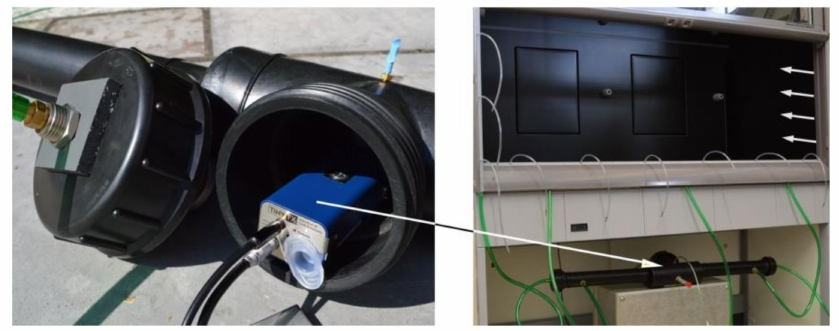
Figure 15. Experimental setup for visualizing the jet flow direction. Installation of the mini fog generator in the jet air distributor